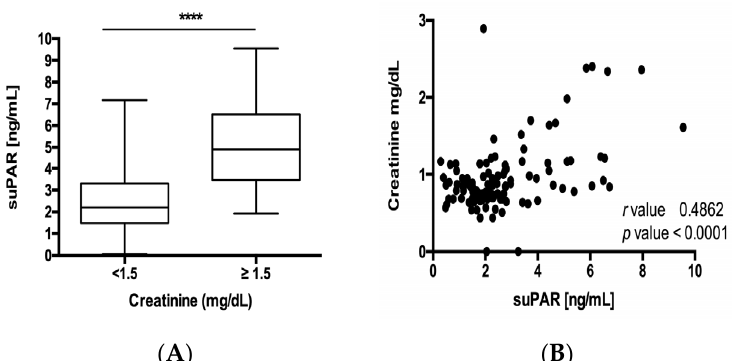
Figure 3. suPAR levels in NET are indicative for renal failure. ( A ) Serum levels of suPAR were significantly higher in patients with elevated serum creatinine. ( B ) Both parameters demonstrated a significant correlation according to spearman rank correlation analysis (Figure 3B). Box plot are displayed, where the bold line indicates the median per group, the box represents 50% of the values. The horizontal lines show minimum and maximum values of calculated nonoutlier values (**** p < 0.0001).